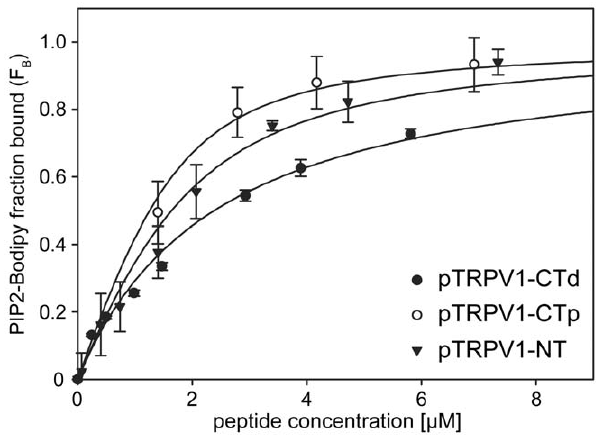
Figure 4. PIP2 recognizes thee independent binding sites within the TRPV1 receptor. Steady-state fluorescence anisotropy measurements of interaction between fluorescently labeled phospha- tidyl inositol-4, 5-bisphosphate (PIP2-Bodipy) and synthetic peptides corresponding to cytoplasmic tails either at the N-terminal region F189- V221 of TRPV1 (pTRPV1– NT), C terminal proximal region K688-K718 of TRPV1 (pTRPV1–CTp), or C-terminal distal region L777-S820 of TRPV1 (pTRPV1–CTd), respectively. PIP2-Bodipy (10 nM) was titrated with indicated concentrations of the peptides and the bound fraction (F B ) of PIP2 Bodipy was calculated according to Equation 1 as described in Material and Methods. The solid lines represent binding isotherms determined by nonlinear least-squares analysis of the isotherm using an Equation 2 as described in Material and Methods. Values represent the mean 6 SD from at least three independent